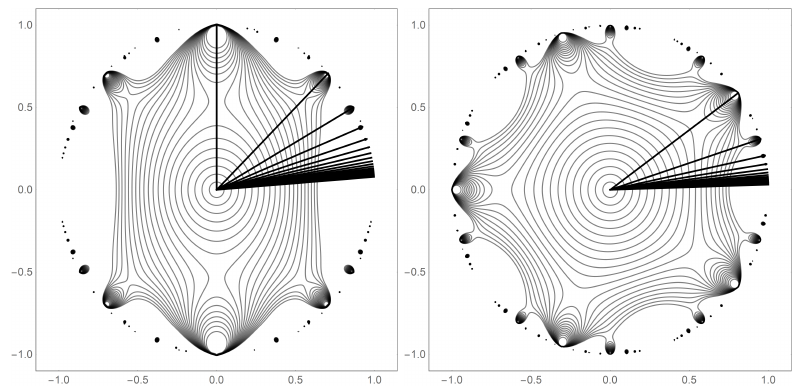
Figure 1. Two examples of centered polygonal lacunary functions, f 18 ( z ) plotted for | f 18 ( z ) | ≤ 1, where g ( n ) = C ( k ) ( n ) (see Equation (3)). The left panel shows the case for k = 2 while the right shows the case of k = 5. The superimposed line segments represent the symmetry angles ( p = 1 through p = 25). The terminus of the line segments at the natural boundary sits at a point where | f 18 ( z ) | does not converge, but the limit value is a bounded 4 p